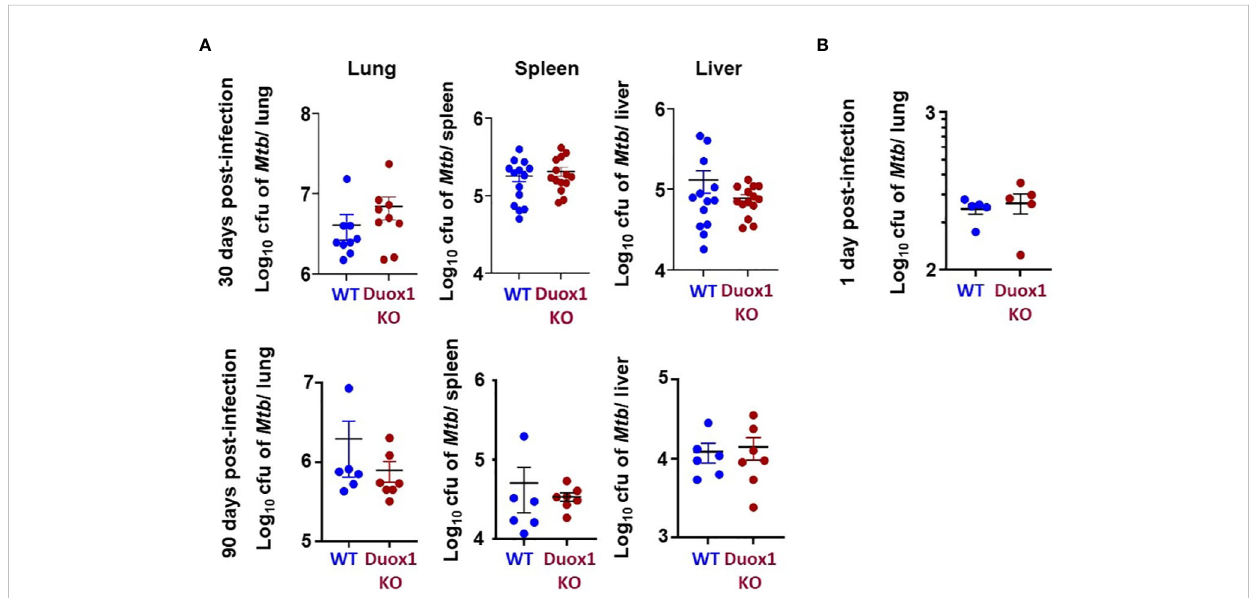
FIGURE 1 Mtb growth in vivo in Duox1 KO mice. Mature Duox1 KO and WT mice were aerogenically infected with 200 CFU of Mtb (Erdman). (A) On 30 and 90 days post- Mtb infection, mice from each genotype were euthanized and lungs (n=9), spleens (n=14) and livers (n=14) were removed for CFU burden assessment by colony counting. (B) On 1 day post-infection, lungs from mice (n=5) of each genotype were removed for CFU counts. Mann-Whitney U test was used to compare CFUs between animal groups. Mean+/-S.E.M. CFU, colony-forming unit; Duox1 KO: Duox1 -de fi cient; WT,